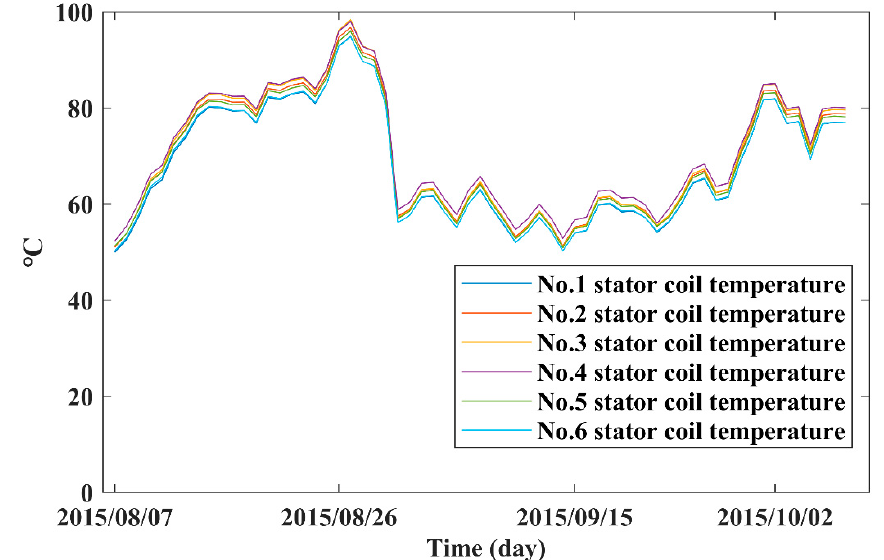
Figure 4. Time-domain diagram of from 1 to 6 stator coil temperatures.